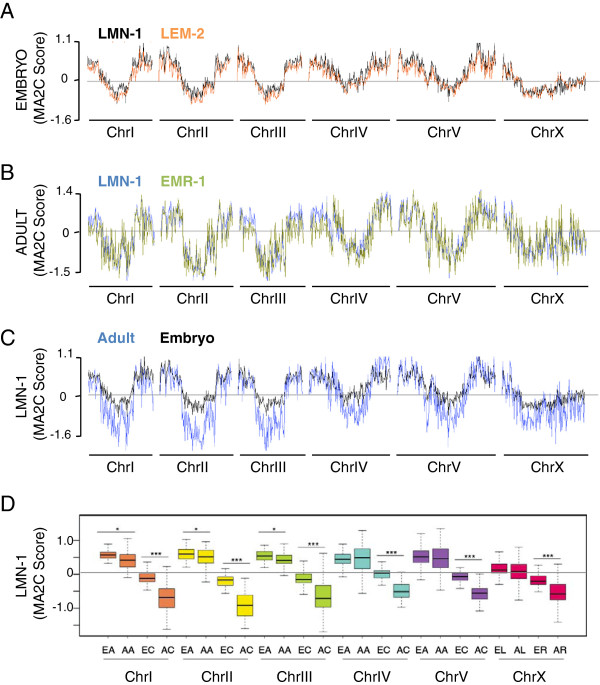
Conservation of nuclear organization during development. (A, B) Global association with chromatin is highly similar among NE proteins, both in embryos (A) for LMN-1 (black) and LEM-2 (orange) and during adulthood (B) for LMN-1 (blue) and EMR-1 (green). Embryonic LMN-1 DamID and LEM-2 ChIP MA2C scores were obtained from [34] and [18], respectively. (C, D) Representation of LMN-1 association as chromosomal profiles (C; embryos in black, adults in blue) and boxplot (D; as in Figure 1). (D) LMN-1 MA2C scores in embryos (E-) and adults (A-) averaged over chromosome arms (-A) and centers (-C), or, for the X chromosome, over the left (-L) and right (-R) portions. Probability values from Wilcoxon rank sum tests are indicated: *P < 0.05, ***P < 10-11. DamID signals at chromosome ends do not differ dramatically between the two developmental stages, whereas chromosome centers are devoid of LMN-1 interaction, particularly in adults. Probe scores were averaged in 100-kb windows for all panels.